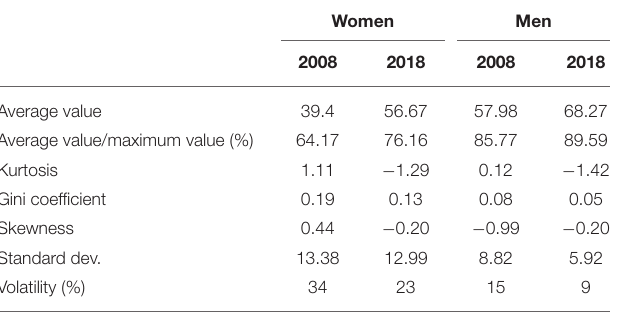
TABLE 5 | KILM 12—descriptive statistics for the years 2008 and 2018.